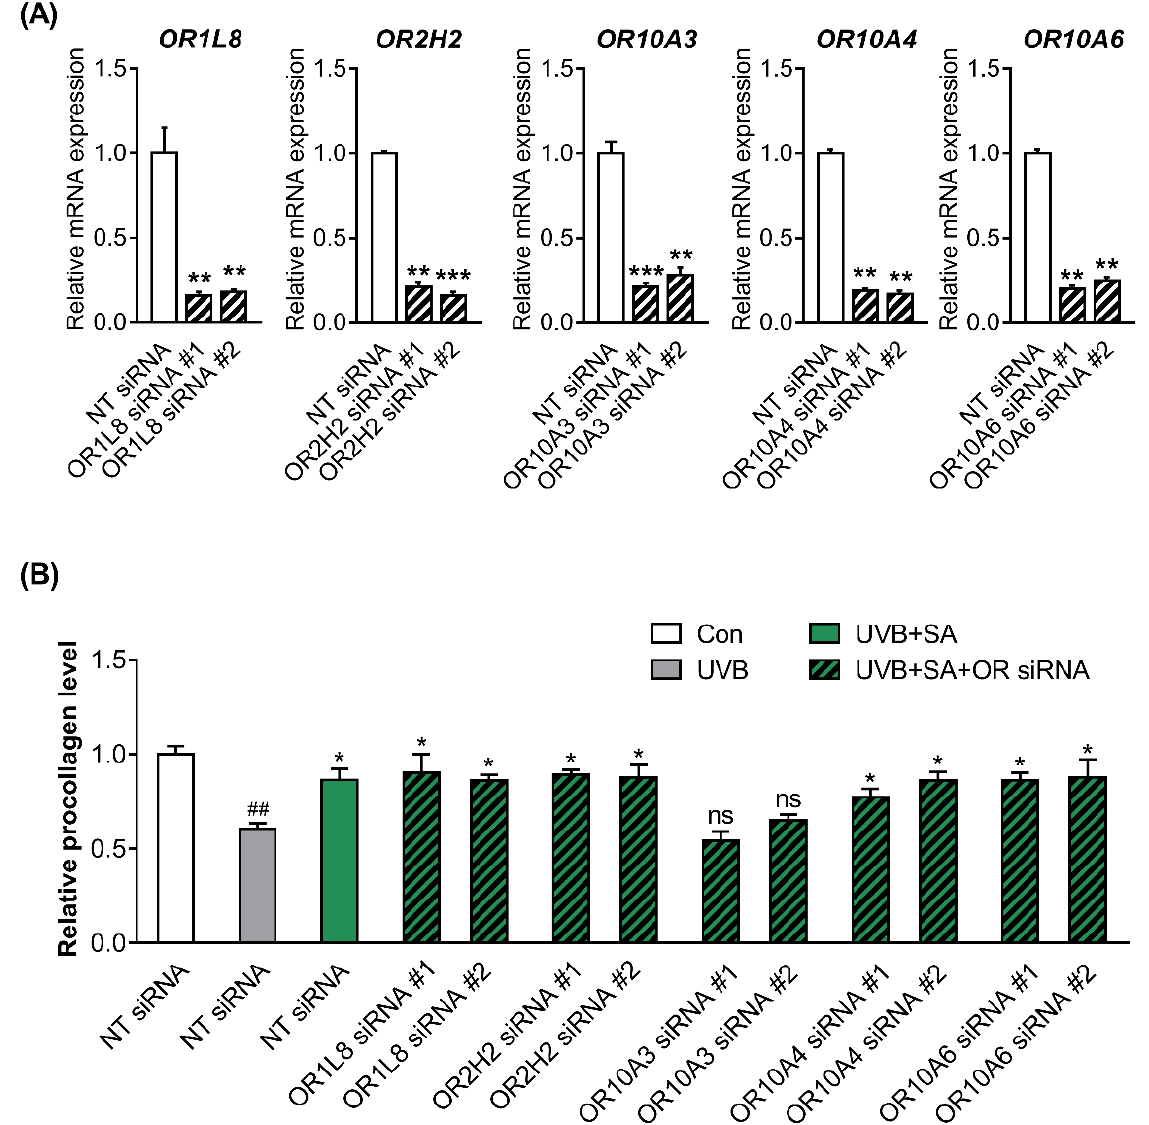
Figure 3. Suberic acid increased the production of collagen through OR10A3 in UVB-exposed Hs68 cells. ( A ) The cells were treated with or without siRNA against 5 ORs (OR1L8, OR2H2, OR10A3, OR10A4 and OR10A6). After treatment for 24 h, the relative mRNA expression of 5 ORs was analyzed. Significant differences between groups are shown as ** p < 0.01; *** p < 0.001 vs. NT siRNA. ( B ) Hs68 cells were treated with suberic acid (SA; 100 uM) or the vehicle after being exposed to UVB. The siRNA against 5 ORs or NT siRNA were pre-treated for 1 h before the suberic acid treatment. Procollagen contents in the supernatant were analyzed. Significant differences between groups are shown as * p < 0.05 vs. Con; ## p < 0.01 vs. UVB; ns, not significant. Results are shown as means ± SEM ( n = 3).